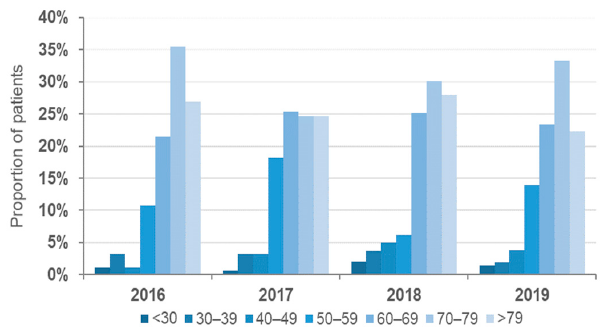
Figure 2. Age distribution of the analyzed VREBI samples.